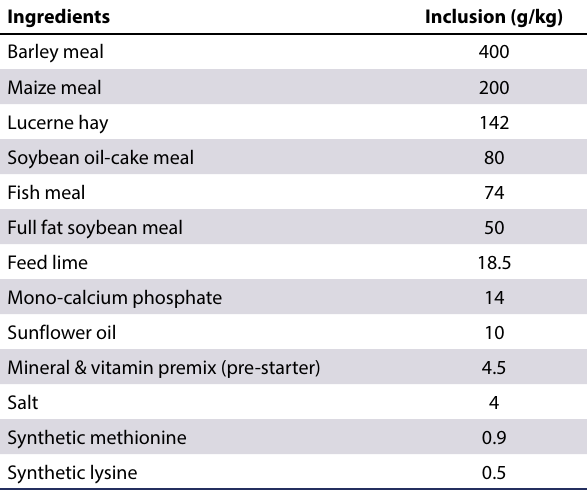
Table IIa: Composition of the basal starter diet (Brand, 2005) fed during Trial 2 Ingredients